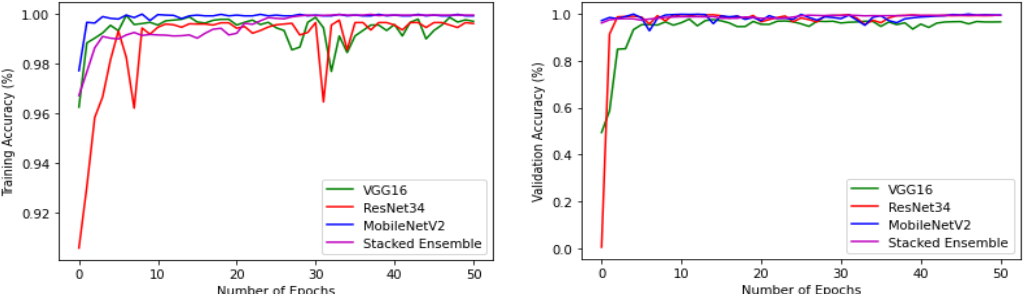
Figure 13. Training and validation accuracy of base-learners with VGG16, Resnet34, MobilenetV2, and Ensemble models, respectively, for the reduced dataset.